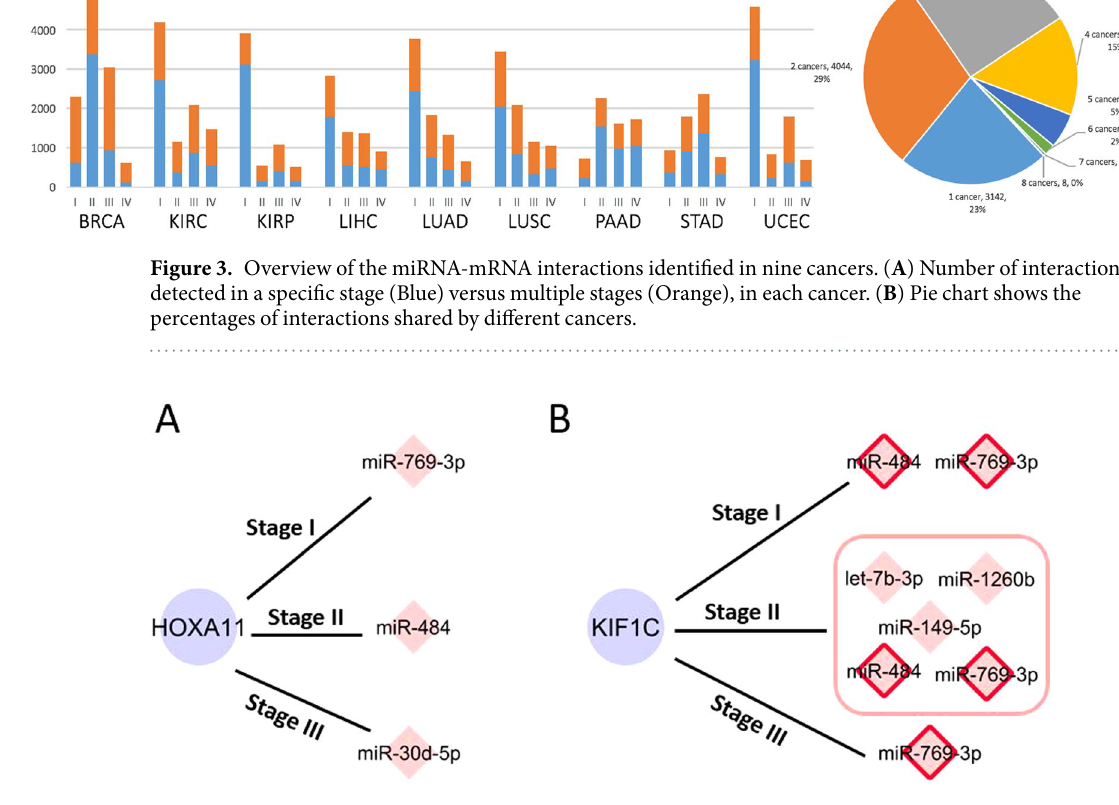
Figure 4. Illustration of the dynamic miRNA-mediated gene regulation (miRNA: pink diamonds and genes: purple nodes). ( A ) Three miRNAs regulate HOXA11 gene in different stages of KIRC. ( B ) Five miRNAs repress the same KIF1C gene in KIRC while the miR-484 and miR-769-3p (pink diamonds with red border) consistently interact with KIF1C across